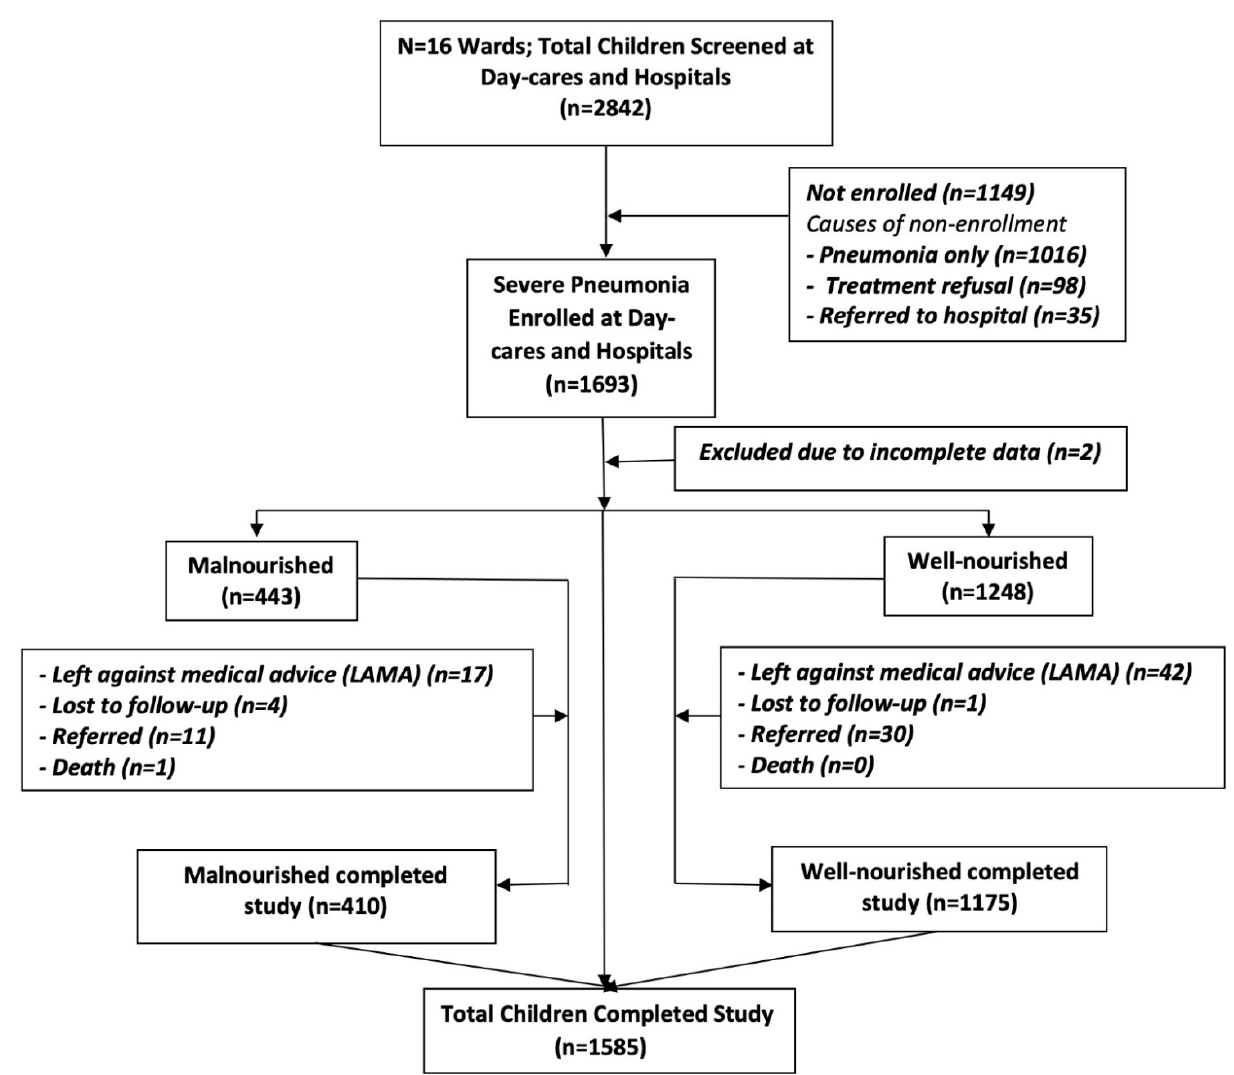
Figure 1. Flow chart of study participants.